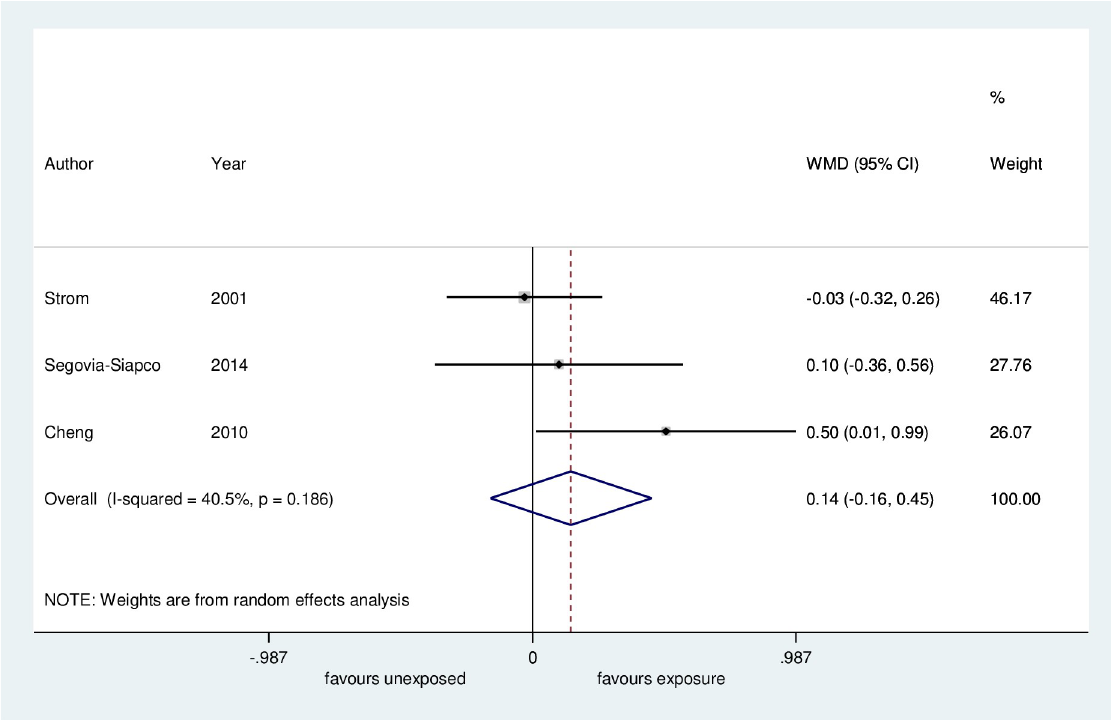
Fig 3. Meta-analysis of mean age of menarche: Soy-based diet versus non-soy-based diet. WMD: Unstandardized mean difference.